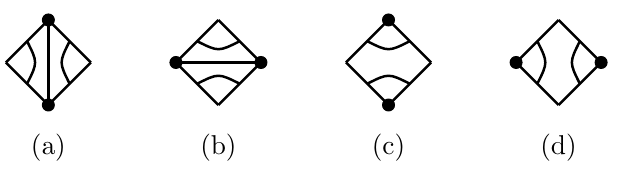
Figure 1 . Each tile on the lattice will take one of the forms shown in panels (a), (b), (c) and (d). The black circles represent the points where the Potts spins lie. The vertices with no black circles are points on the dual